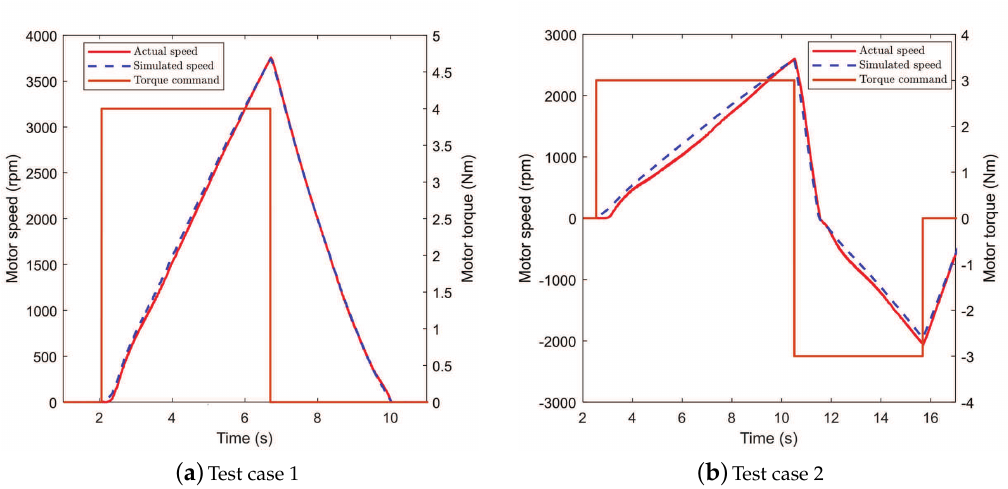
Figure 4. Simulated model response versus measured data. ( a ) Test case 1; ( b ) Test case 2. The identified and default parameters of the powertrain system are listed in Table